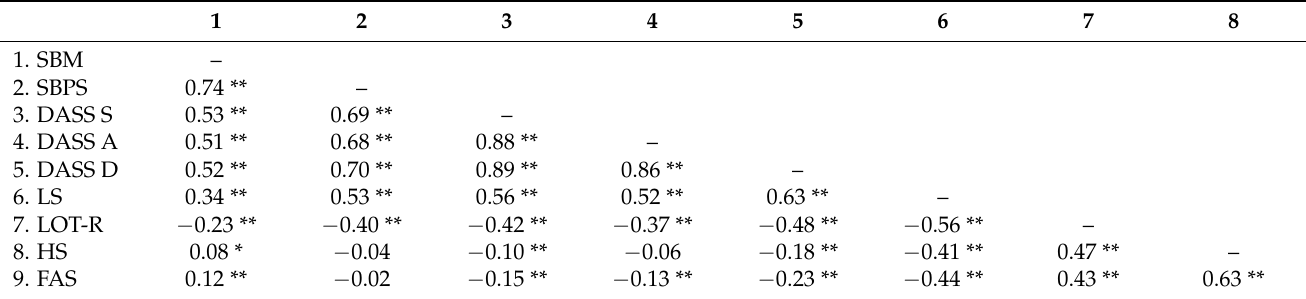
Table 3. Correlations Between Boredom and Psychological Distress, Loneliness, Optimism, and